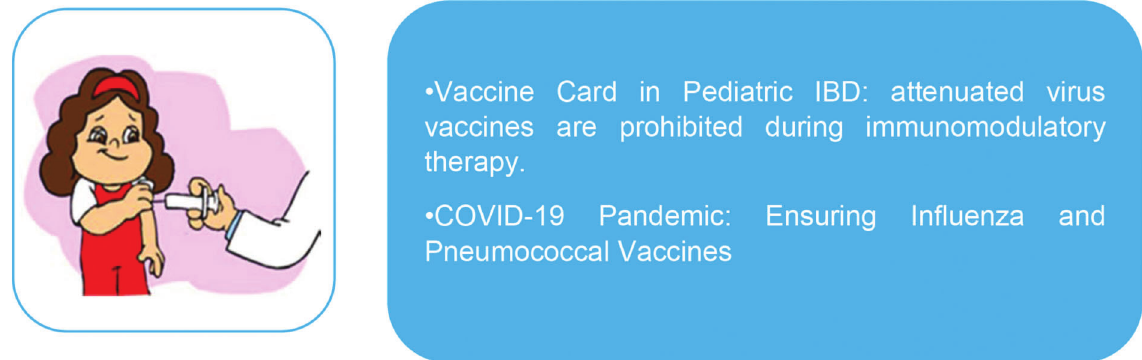
Figure 4 - Recommendations on vaccines for pediatric IBD during the COVID 19 pandemic. Modified by Dipasquale & Romano